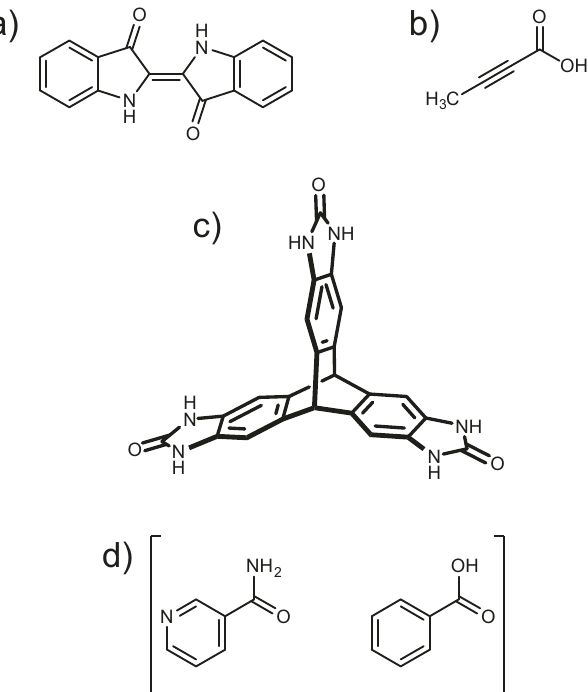
Fig. 1 Molecular crystal systems studied in this work. a Indigo, b tetrolic acid, c TTBIand d